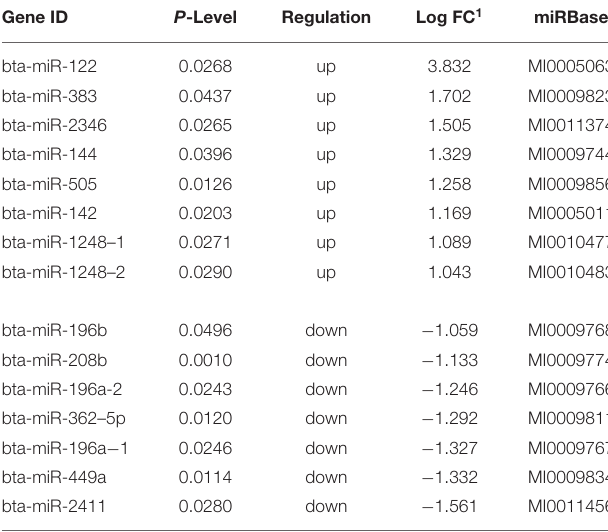
TABLE 5 | Differentially expressed miRNA in skeletal muscle biopsies at d 124 on concentrates compared to d0. Gene